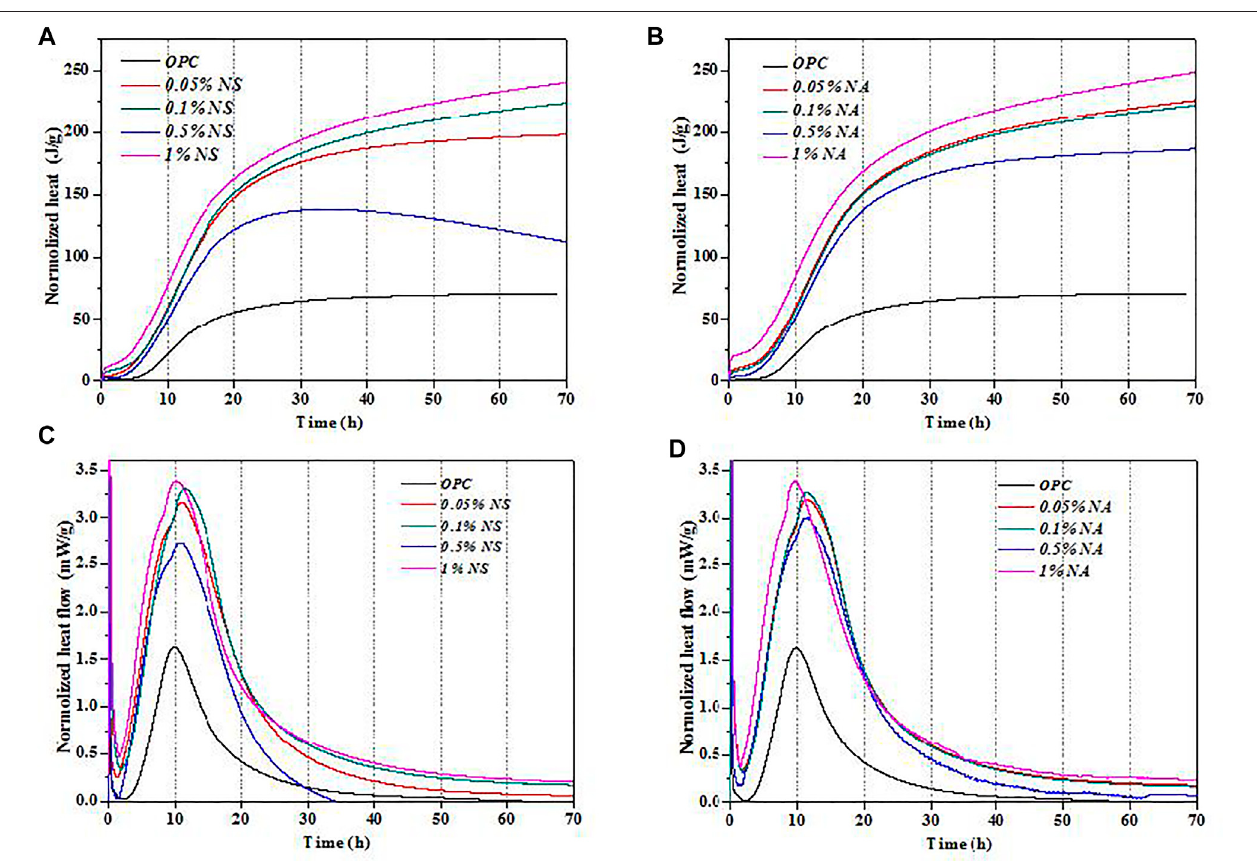
FIGURE 6 | The effect of nanomaterials on the hydration evolution of nano-modi fi ed cement paste. (A) Total heat curves of the samples modi fi ed with nano SiO 2 , (B) total heat curves of the samples modi fi ed withnano Al 2 O 3 , (C) heat fl ow evaluation ofthe nano SiO 2 modi fi ed cement paste, and (D) heat fl ow evaluation of thenano Al 2 O 3 modi fi ed cement paste.